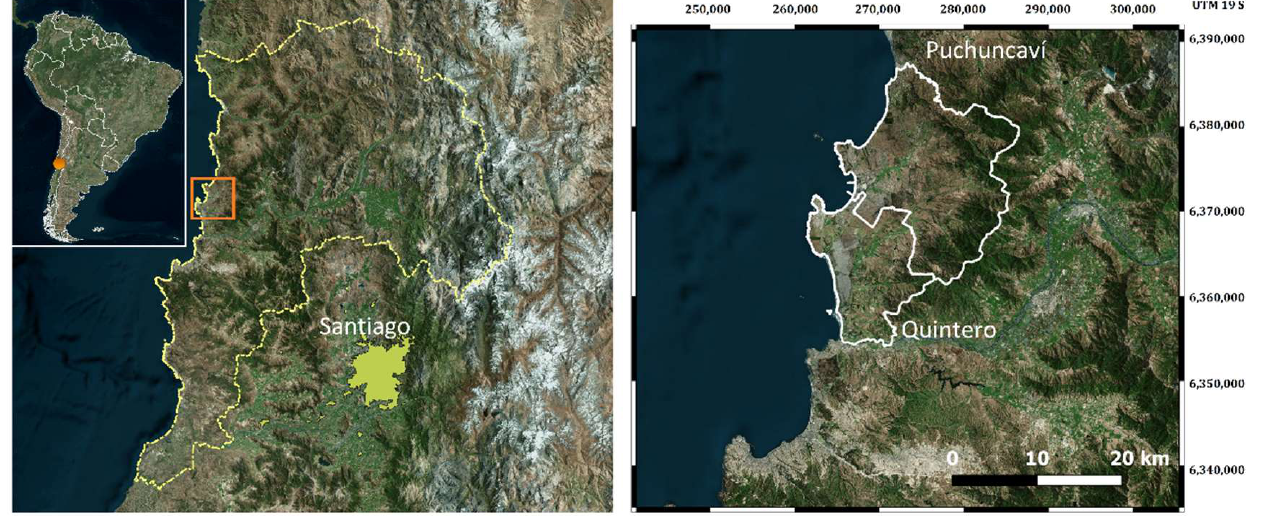
Figure 5. Location of the coastal cities where the sensor training and testing were conducted.